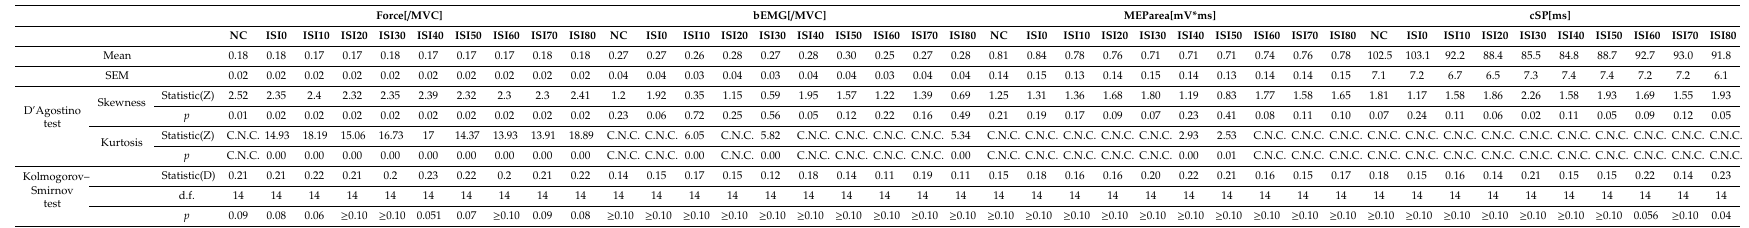
Table 2. Mean value and D’Agostino and Kolmogorov–Smirnov tests in the second experiment. Force[ / MVC] bEMG[ / MVC] MEParea[mV*ms] cSP[ms] NC ISI0 ISI10 ISI20 ISI30 ISI40 ISI50 ISI60 ISI70 ISI80 NC ISI0 ISI10 ISI20 ISI30 ISI40 ISI50 ISI60 ISI70 ISI80 NC ISI0 ISI10 ISI20 ISI30 ISI40 ISI50 ISI60 ISI70 ISI80 NC ISI0 ISI10 ISI20 ISI30 ISI40 ISI50 ISI60 ISI70 ISI80